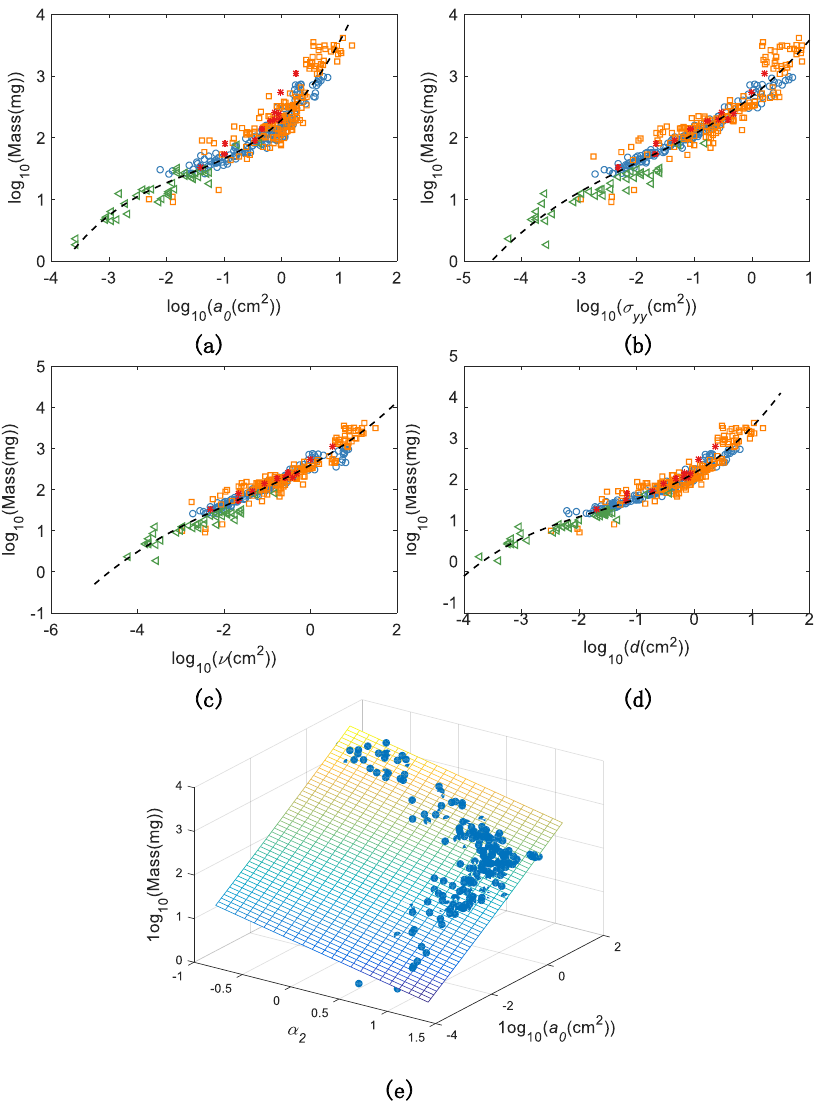
Figure 3. The fitting relation of RCS parameters and mass: ( a ) logarithm of 𝑎 0 versus mass; ( b ) logarithm of 𝜎 𝑦𝑦 versus mass; ( c ) logarithm of 𝜈 versus mass; ( d ) logarithm of 𝑑 versus mass; ( e ) logarithm of 𝑎 0 and 𝛼 2 versus mass. Note: For (a – d), □ represents dataset D; ◁ represents dataset L; ❉ represents dataset L; and ○ represents dataset K. Table 4. Comparison of mean relative error (MRE) between traditional methods and SVR in estimating insect mass.